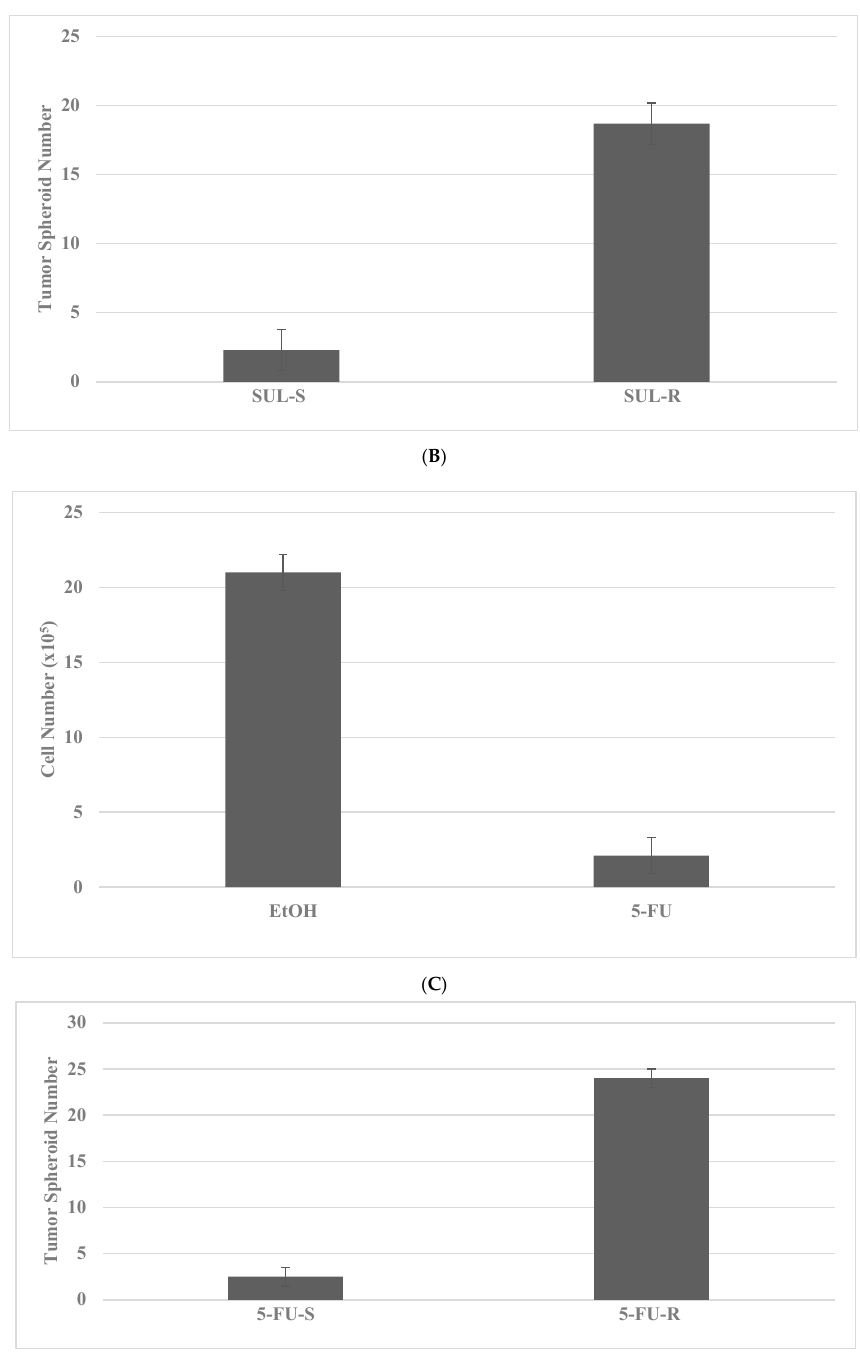
Figure 3. Isolation of drug-resistant putative stem cells in colon cancer models. ( A ) Deceased viable cell number by treatment with SUL in SUL-S cells. EtOH versus SUL p = 0.01 . ( B ) Increased tumor spheroid number by treatment with SUL in SUL-R cells. SUL-S versus SUL-R p = 0.01. ( C ) Decreased viable cell number by treatment with 5-FU in 5-FU-S cells. EtOH versus 5-FU p = 0.01. ( D ) Increased tumor spheroid number by treatment in 5-FU-R cells5-FU-S versus 5-FU-R p = 0.01. SUL, sulindac; SUL-S, SUL sensitive; SUL-R, SUL resistant; 5-FU, 5-fluoro-uracil; 5-FU-S, 5-FU sensitive; 5-FU-R, 5- FU resistant (Data summarized from [36,37]).